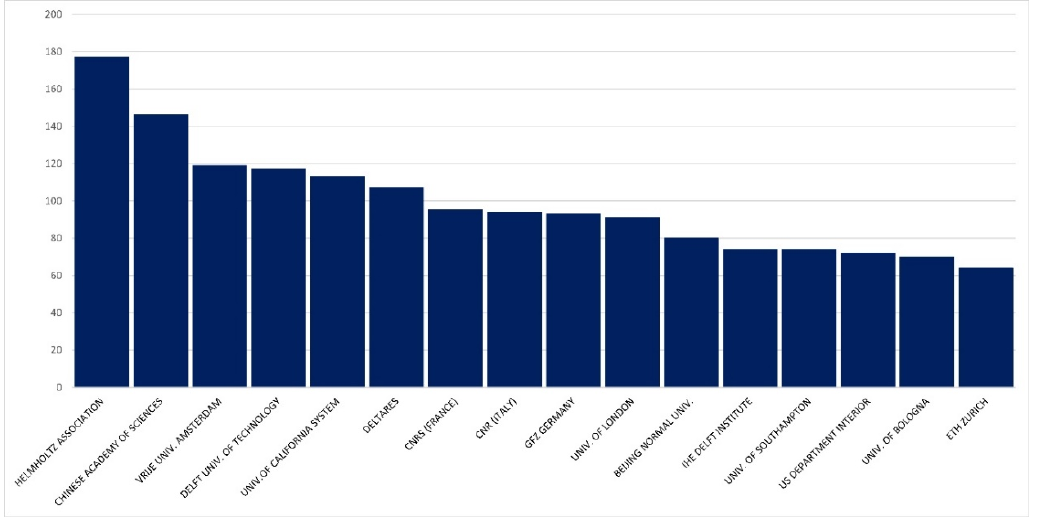
Figure 7. Bar chart showing the number of FRAs references (records) in WoS databases related to the main international R&D Institutions.